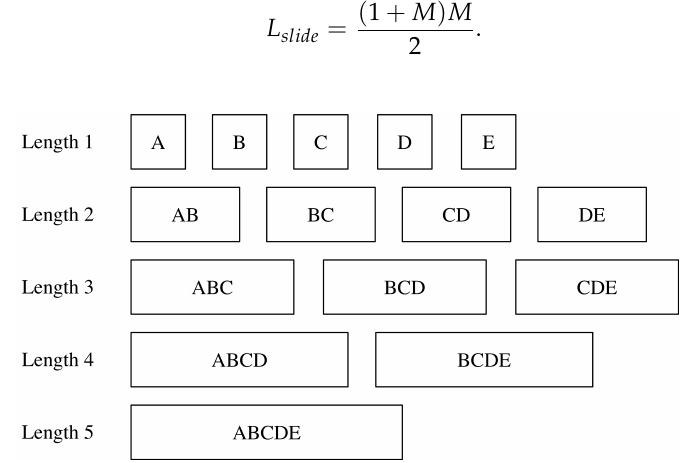
Figure 7. An example for increasing number of sequences through adding sliding window. In this case, the original trajectory has 5 fingerprints with ids of A, B, C, D and E